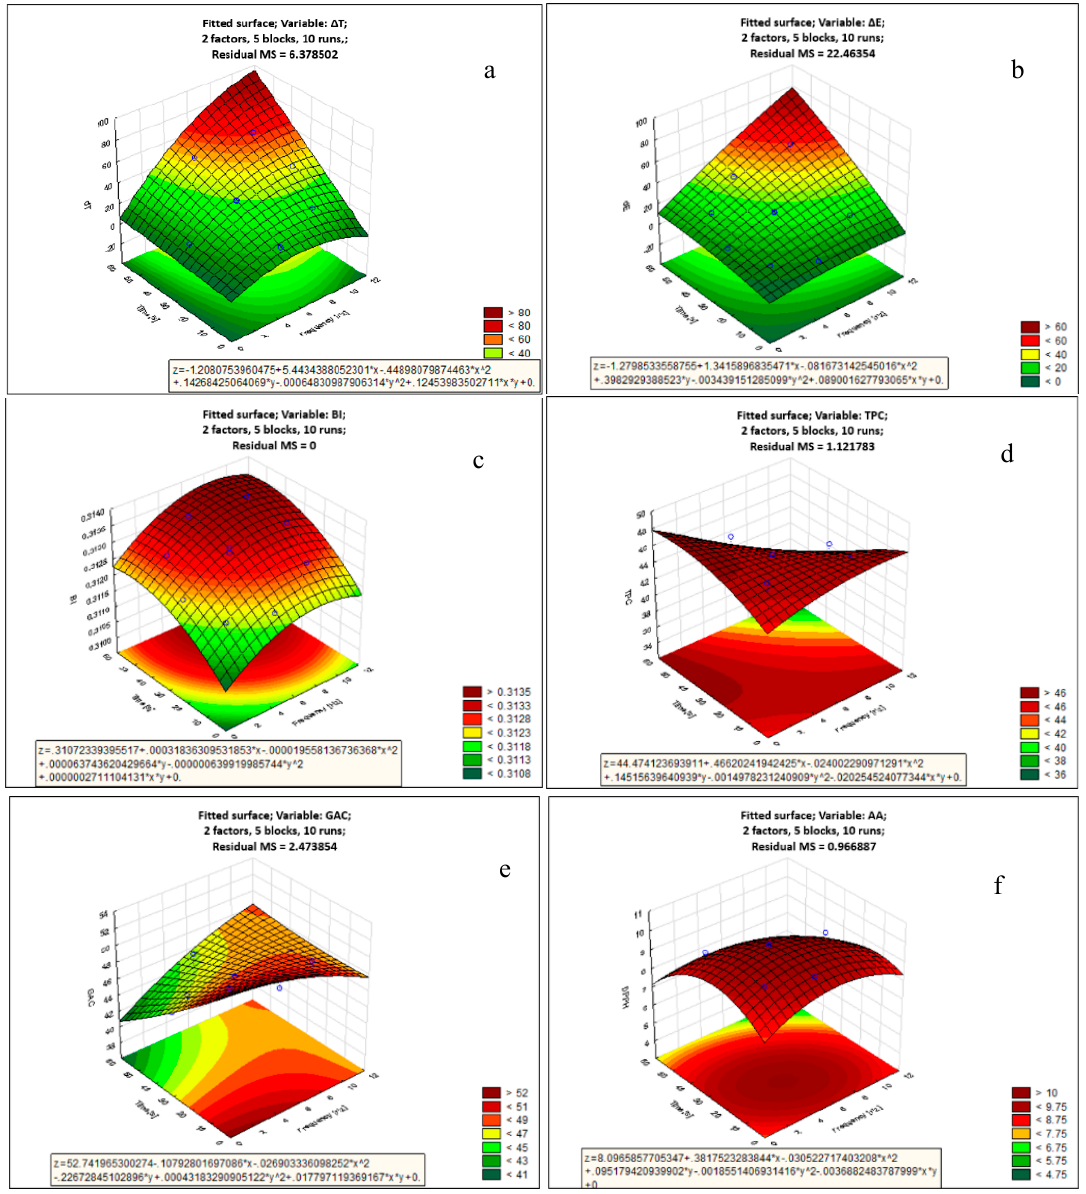
Figure 5. RSM plots showing the impact of PL on the properties of gallic acid aqueous solution. from top to bottom: a) temperature change, Δ T; b) total colour difference, Δ E; c) browning index, BI; d) Total phenolic content, TPC; e) Gallic acid content, GAC; f) antioxidant capacity.